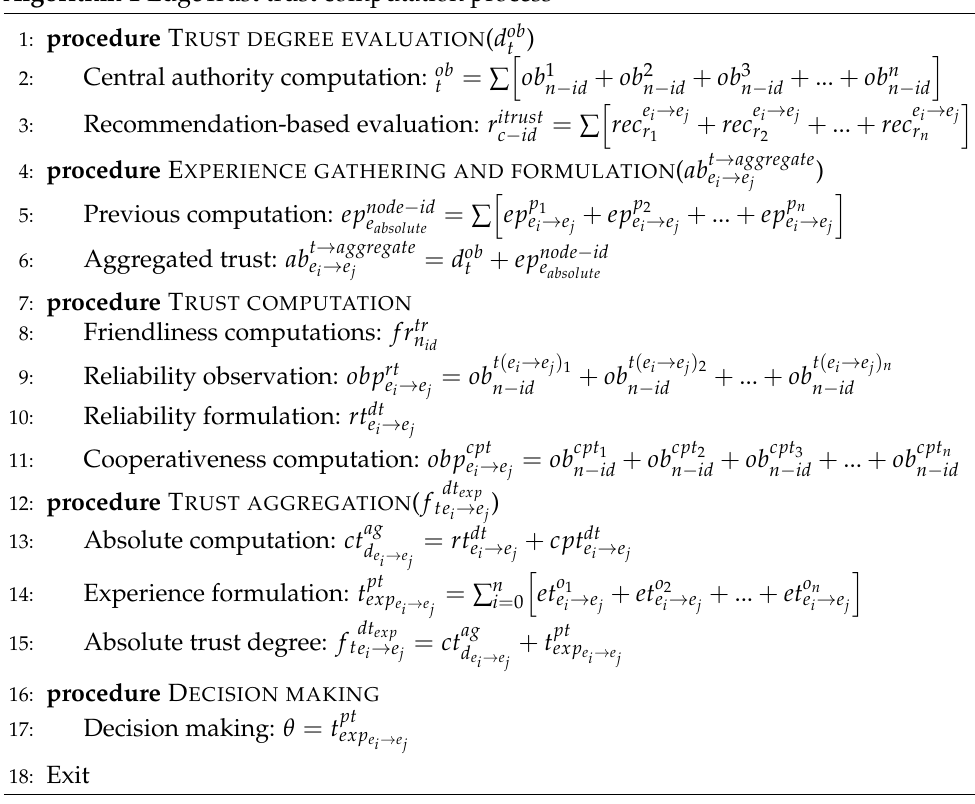
Algorithm 1 EdgeTrust trust computation